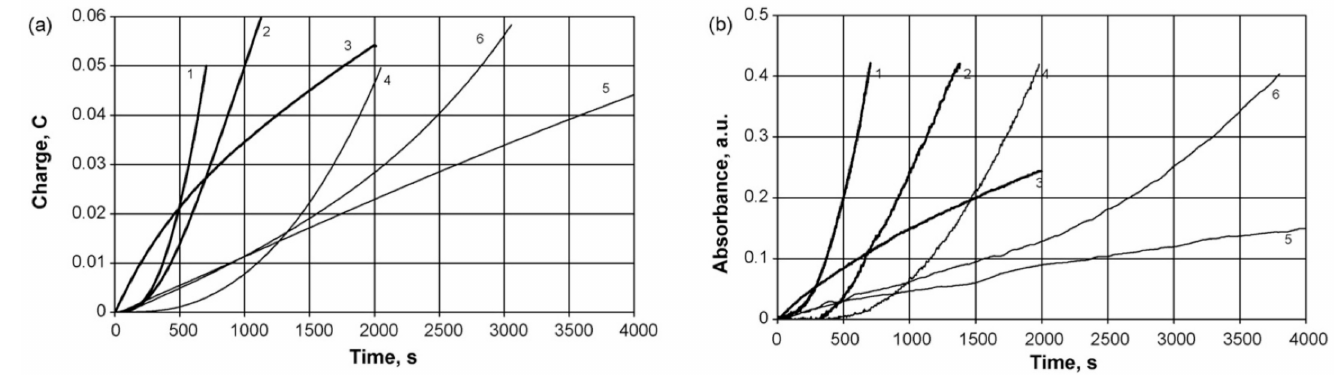
Figure 12. Time dependencies of the charge ( a ) and absorbance at λ max ( b ) during the potentiostatic synthesis of polyaniline in aqueous solutions containing PAMPSA and HCl at 0.75 V vs. s.s.c.e. at different concentrations: 1: 0.0375 M aniline, 0.075 M PAMPSA; 2: 0.025 M aniline, 0.05 M PAMPSA; 3: 0.0125 M aniline, 0.025 M PAMPSA; 4: 0.0375 M aniline, 0.75 M HCl; 5: 0.0375 M aniline, 0.075 M HCl; 6: 0.0375 M aniline, 0.25 M HCl. Reprinted from Electrochimica Acta Volume 53, A.A. Nekrasov et al., “Electrochemical synthesis of polyaniline in the presence of